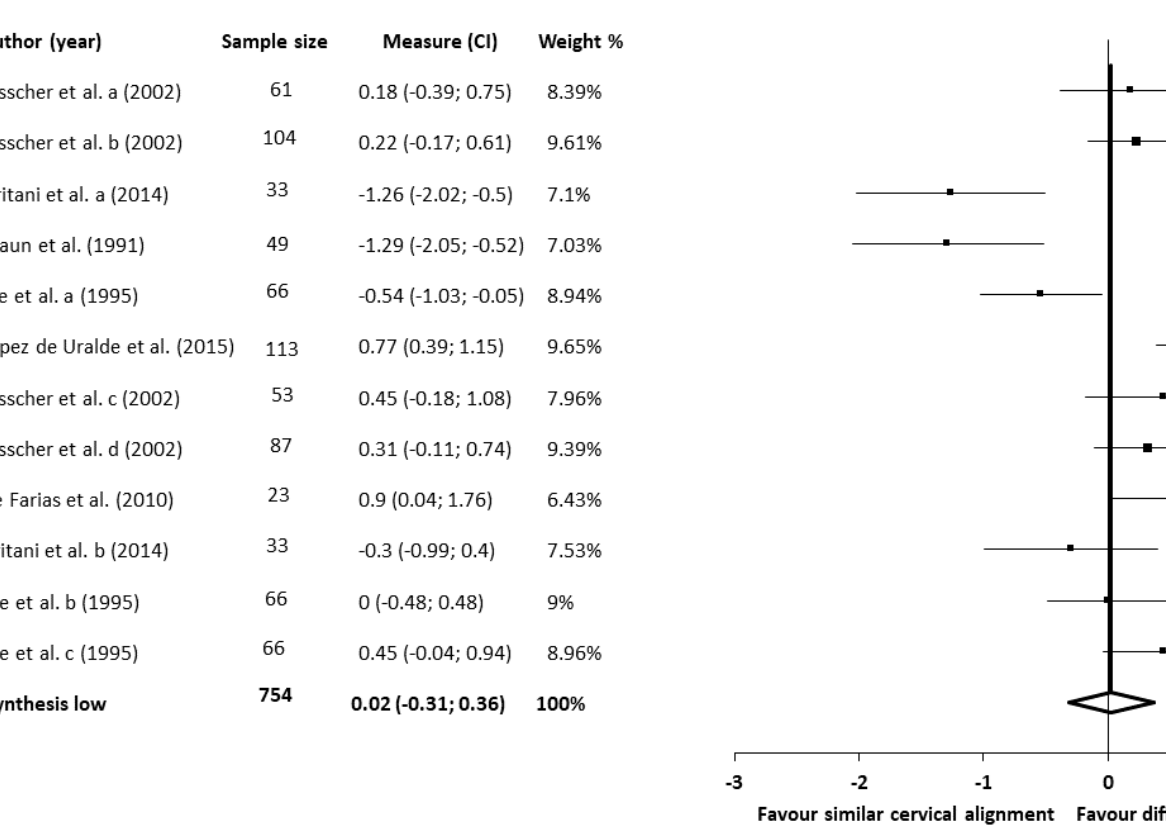
Figure 4. Synthesis forest plot for the cervical spine alignment. SMD, standardized mean difference. This forest plot summarizes the results of six included studies (sample size, standardized mean differences (SMDs), and weight). The small boxes with the squares represent the point estimate of the effect size and sample size. The lines on either side of the box represent a 95% confidence interval (CI). The horizontal axis represents whether the quantitative analysis is for or against the different cervical alignment in patients with TMD.